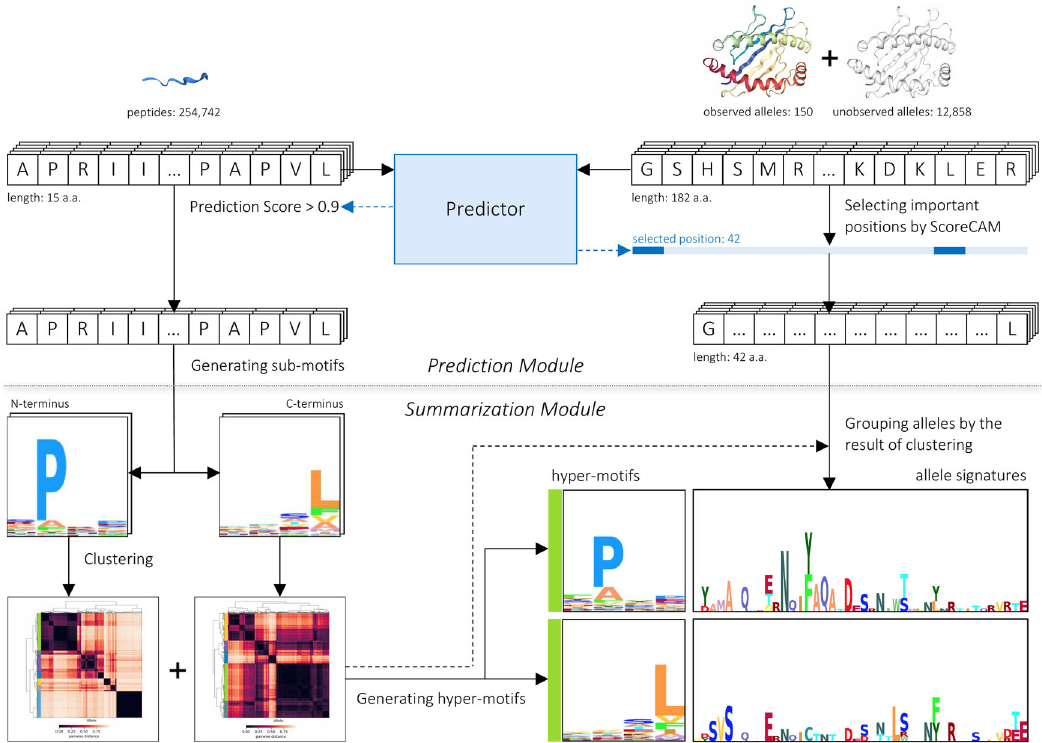
Fig. 1 An overview of MHCfovea. MHCfovea, a deep learning-based framework, contains a prediction module and a summarization module that infers the relation between MHC-I sequences and peptide-binding motifs. First, the predictor, an ensemble model of multiple convolutional neural networks (CNN models), was trained on 150 observed alleles. In the predictor, 42 important positions were highlighted from MHC-I sequence (182 a.a.) using ScoreCAM. Next, we made predictions on 150 observed alleles and 12,858 unobserved alleles against a peptide dataset (number: 254,742) and extracted positive predictions (score >0.9) to generate the binding motif of an allele. Then, after clustering the N-terminal and C-terminal sub-motifs, we built hyper-motifs and the corresponding allele signatures based on 42 important positions to reveal the relation between binding motifs and MHC-I